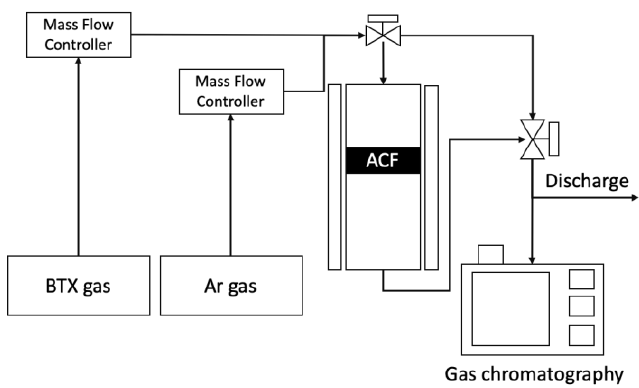
Figure 3. Process flow diagram of the VOCs adsorption–desorption system. BTX: benzene, toluene, and xylene.